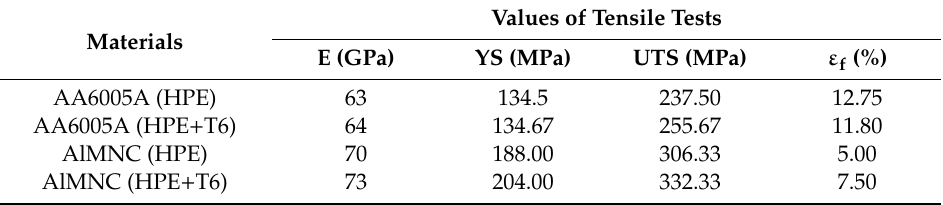
Table 5. Tensile testing results of the AA6005A-HEBM and AlMNC-HEBM. Young’s modulus (E), yield stress (YS, 0.2% o ff set), ultimate tensile strength (UTS), strain to failure ( ε f ), and average dimple size in as-extruded (HPE) and aged-hardening (T6)